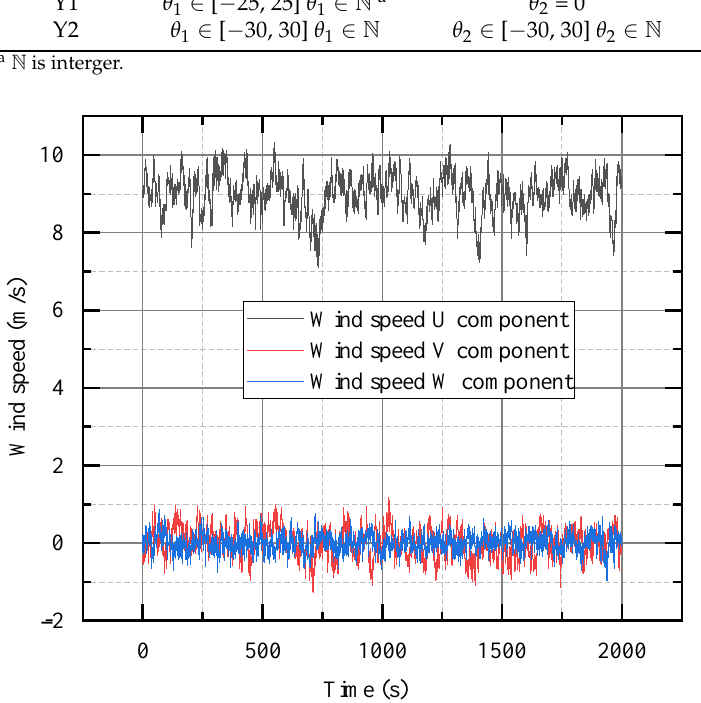
Figure 5. Precursor of wind speed at 9 m/s and TI at 5% (P7).